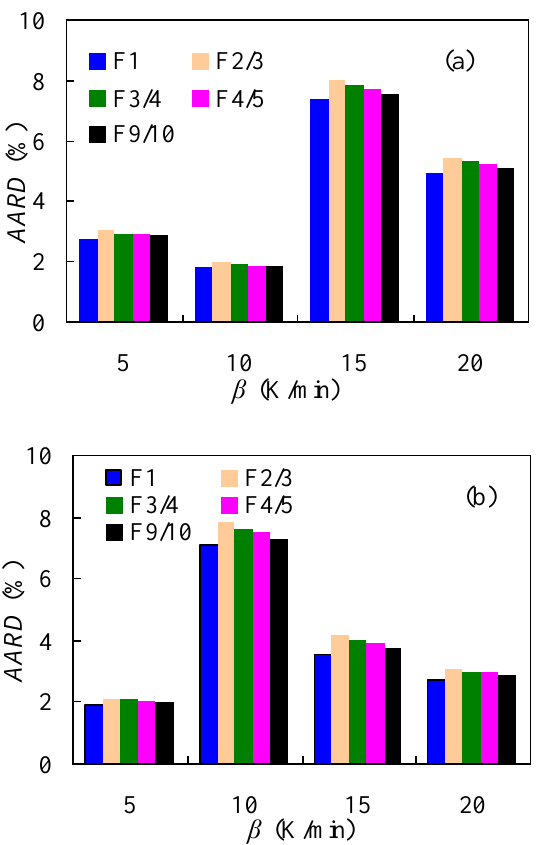
Figure 7. The AARD results under different β values for some reaction models with the CR method: ( a ) in nitrogen and ( b ) in air. Table 3. Thermodynamic parameters of ∆ H , ∆ S, and ∆ G calculated for thermal degradation of nylon-6 tennis string wastes.